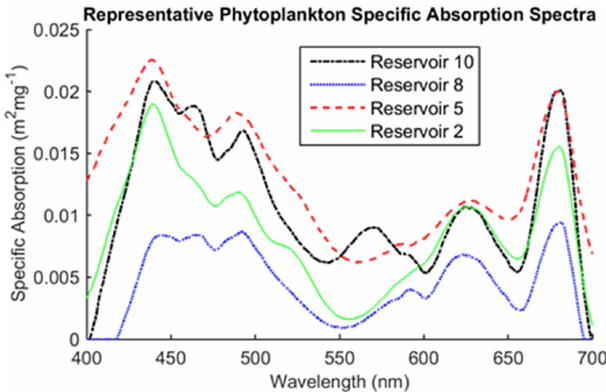
Figure 5. R 2 values between modeled and measured constituent concentrations produced by every combination of Q from Table 2, objective function, and viewing angle.